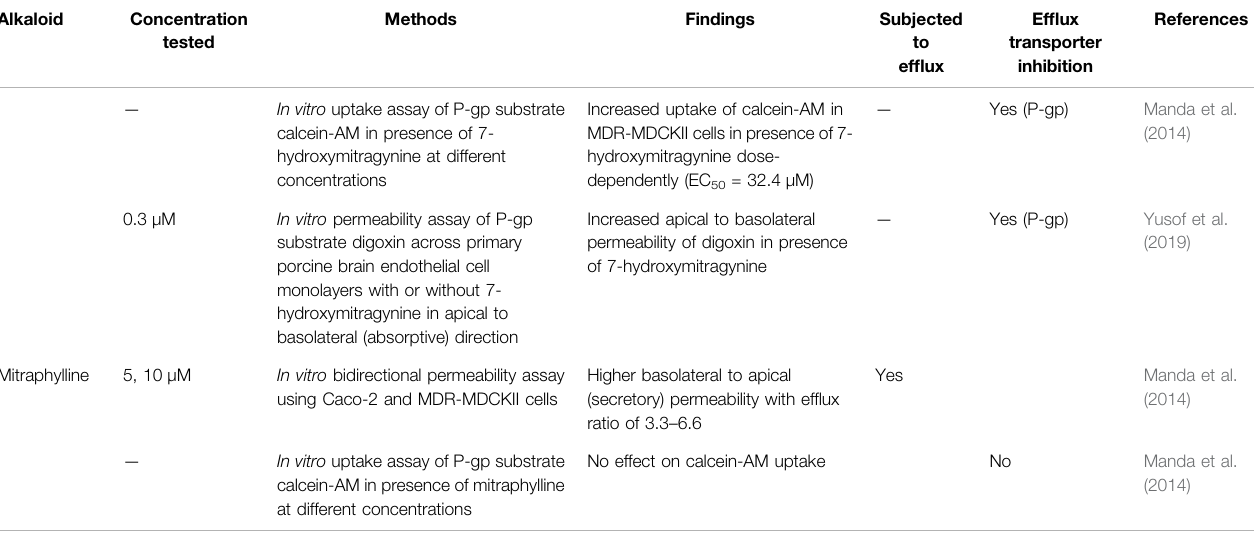
TABLE 4 | ( Continued ) Functional interactions of kratom alkaloids with ef fl ux